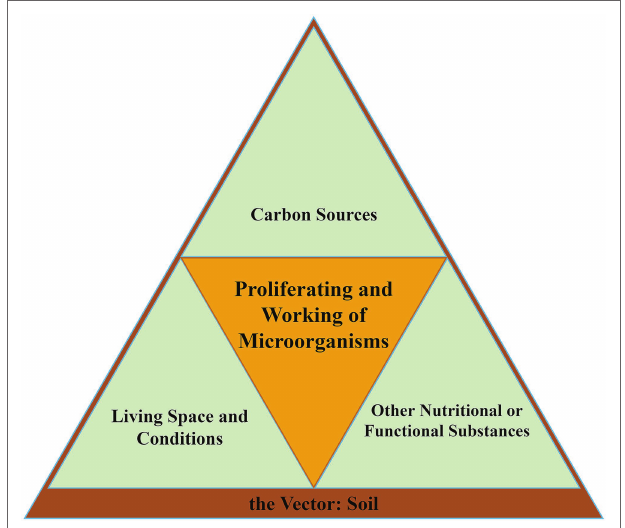
FIGURE 2 | Three basics and a vector for proliferating and working of soil